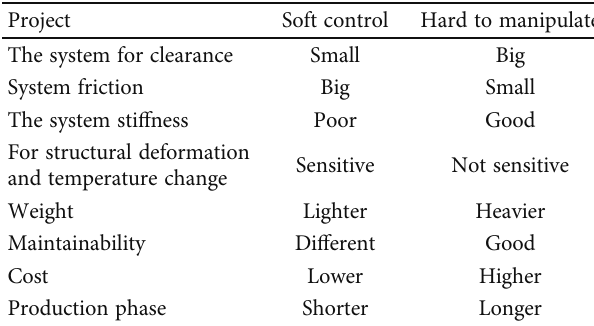
Figure 4: Pitch and roll control isolation mechanism. Table 1: Soft and hard control